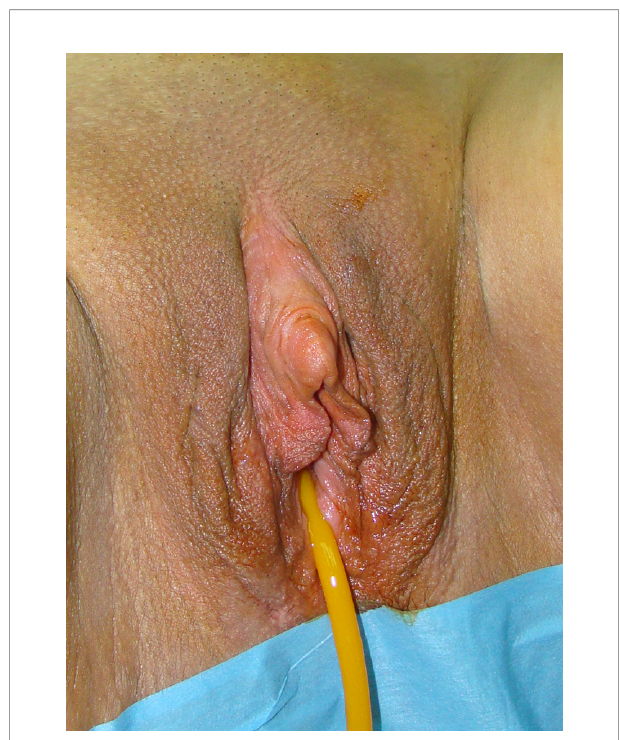
FIGURE 1 | Preoperative appearance of female genitalia after topical testosterone treatment.